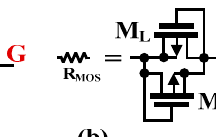
Figure 3. MI-BD MOS transistor ( a ), and realization of R MOS ( b ).